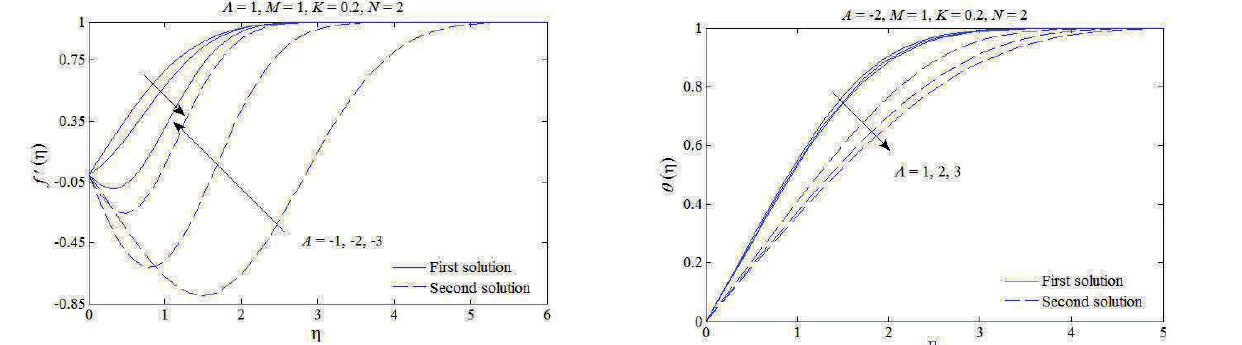
Fig. 10: Velocity profiles for different values of A .